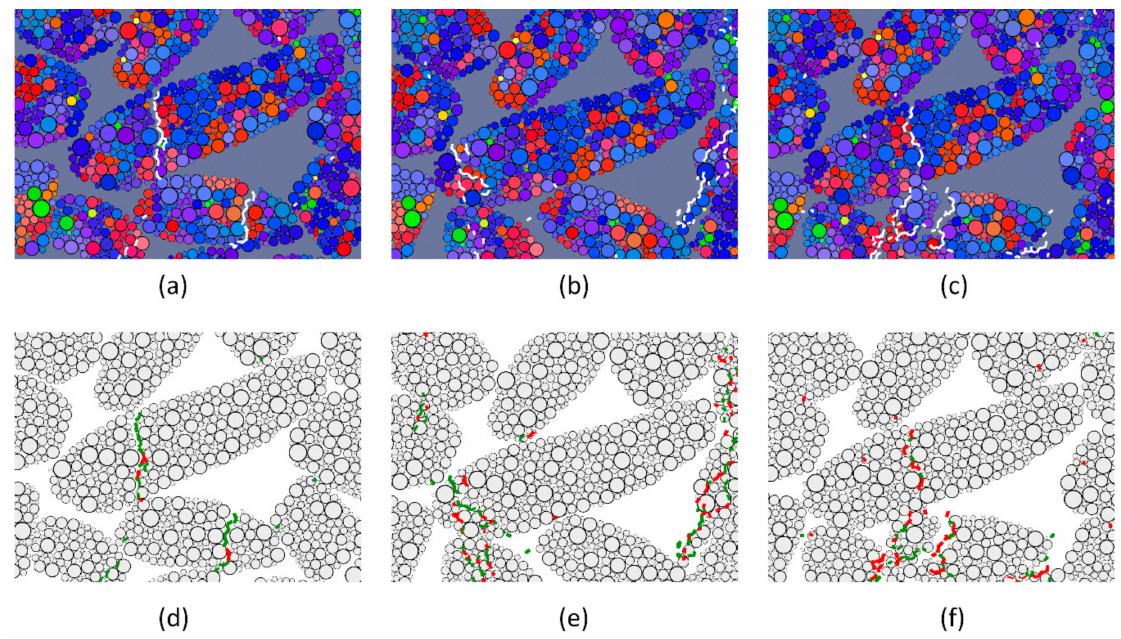
Figure 14. Image sections of the simulations with low resolution showing the effect of the grain boundary factor z Boundary on the breakage pattern: z Boundary = 0.6 ( a , d ); z Boundary factor = 1.0 ( b , e ); z Boundary = 1.4 ( c , f ). The images in the first row ( a – c ) show the influence of the mineral microstructure on the breakage pattern (white lines). In the images of the second row ( d – f ) the focus is on the crack type (green lines: intergranular cracks; red lines: intragranular